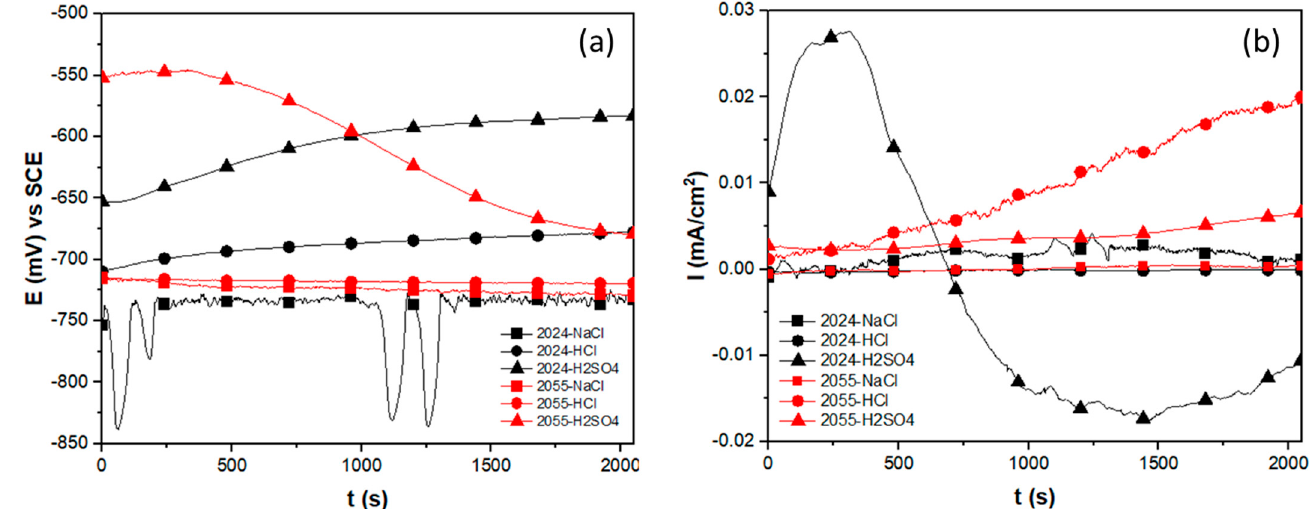
Figure 6. Electrochemical potential noise ( a ) and electrochemical current noise ( b ) noise-time series for AA2024 and 2055 alloys in T0 heat treatment condition, exposed in 3.5 wt. % NaCl, 1 wt. % HCl, and 1 wt. % H 2 SO 4 solutions.